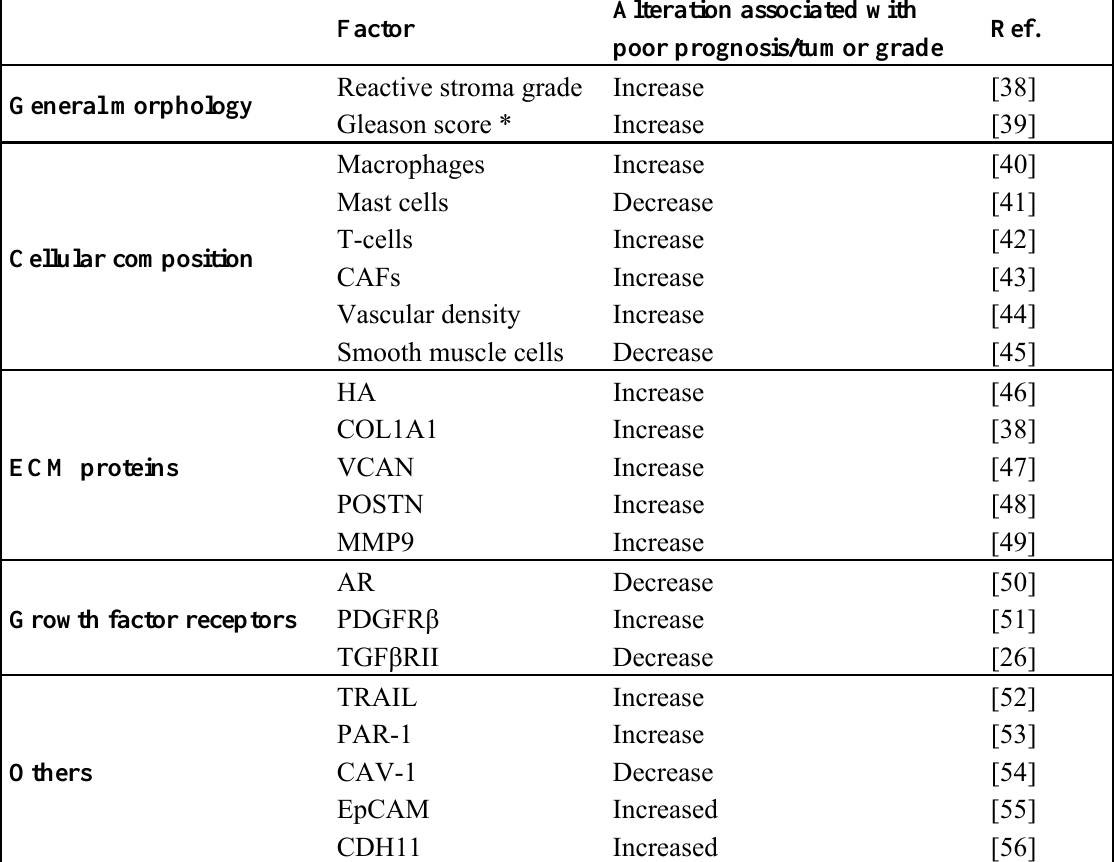
Table 1. Factors associated with prognosis or tumor grade in prostate cancer stroma. Alteration associated with Factor poor prognosis/tumor grade